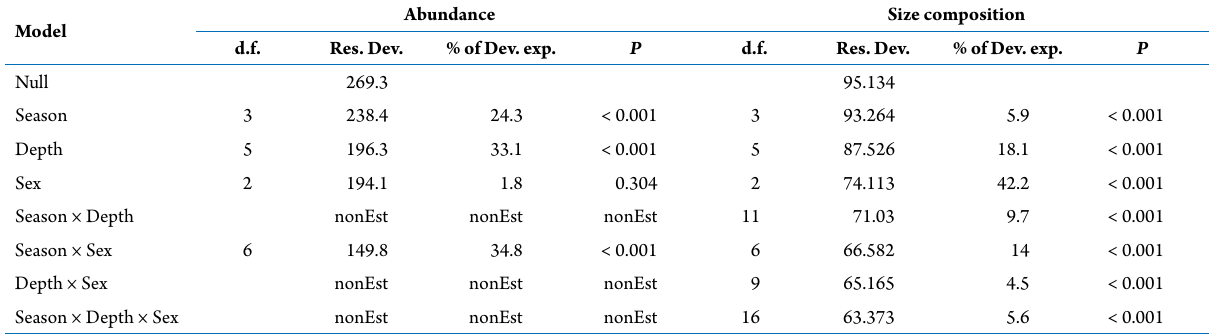
Table 3. Results from Generalized Linear Models (GLMs) for effects of season (spring, summer, autumn, winter), depth stratum (100, 200, 300, 400, 500, 600 m) and sex (male, ovigerous female, non-ovigerous female) on abundance and size composition of Plesionika edwardsii in the Azorean region during the period 1999–2000. Detailed model selection procedure is in Tab.